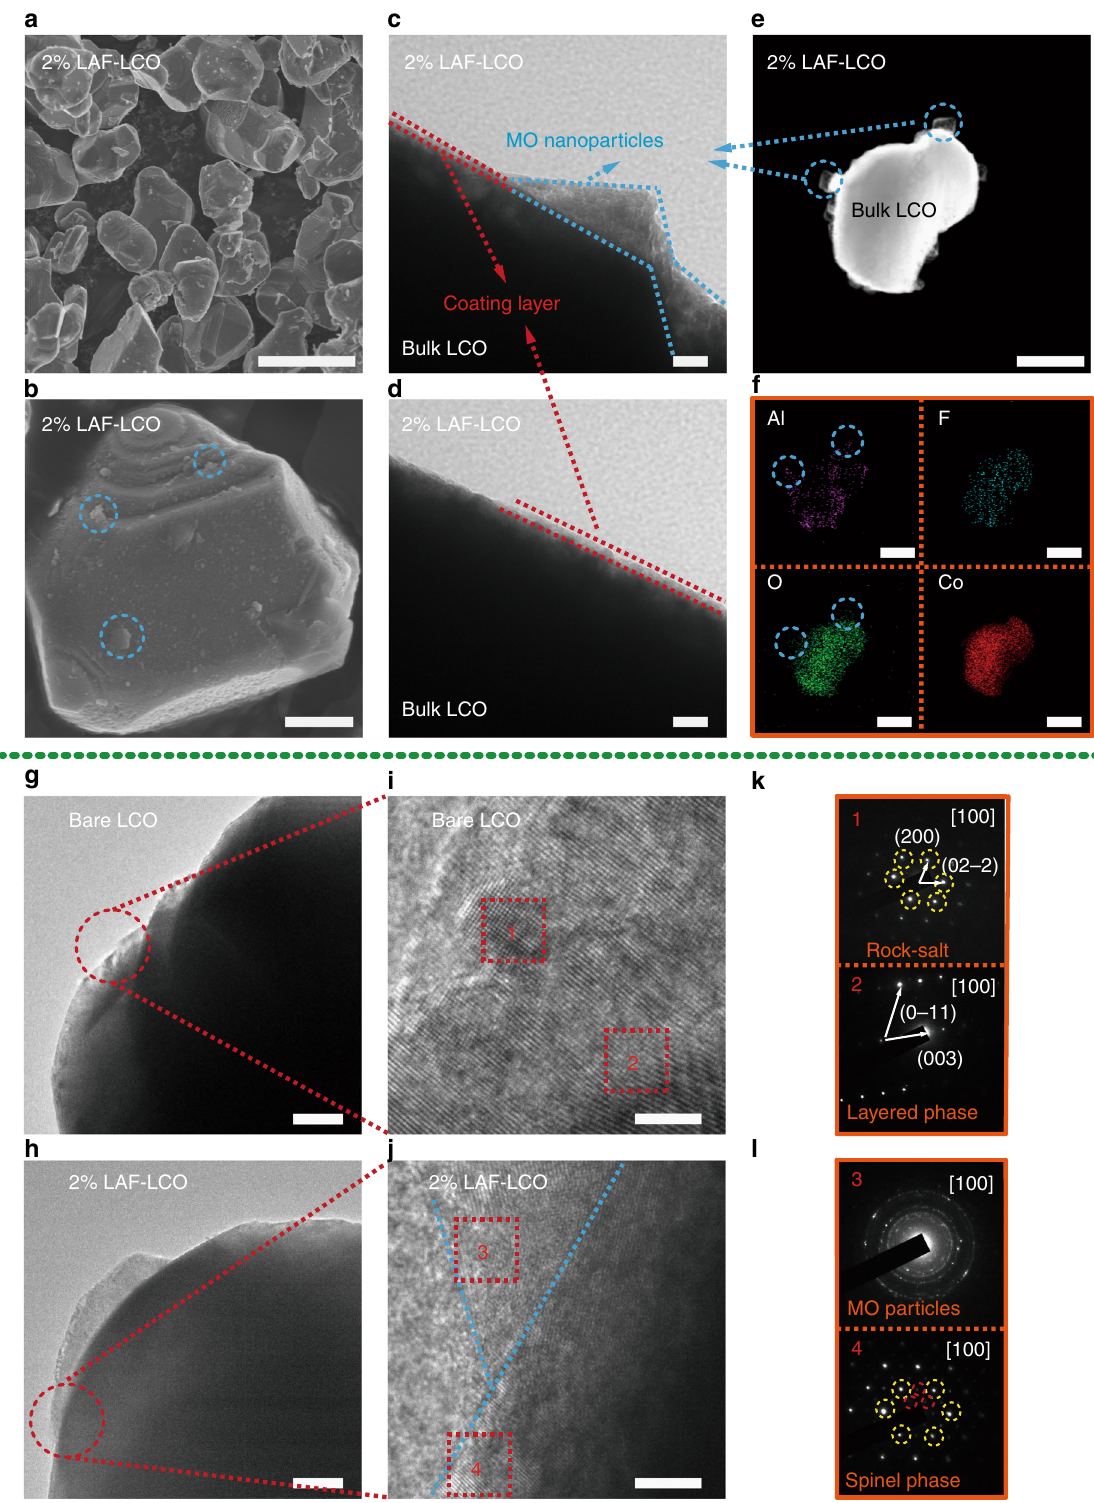
Fig. 2 Morphological and structural analyses of LAF-LCO. a , b SEM images of 2% LAF-LCO particles at different magni fi cations. Scale bar: 5 μ m and 2 μ m, respectively. c , d TEM images of 2% LAF coating layers and MO nanoparticles. Scale bar: 20 nm. e High magni fi ed TEM image of 2% LAF-LCO